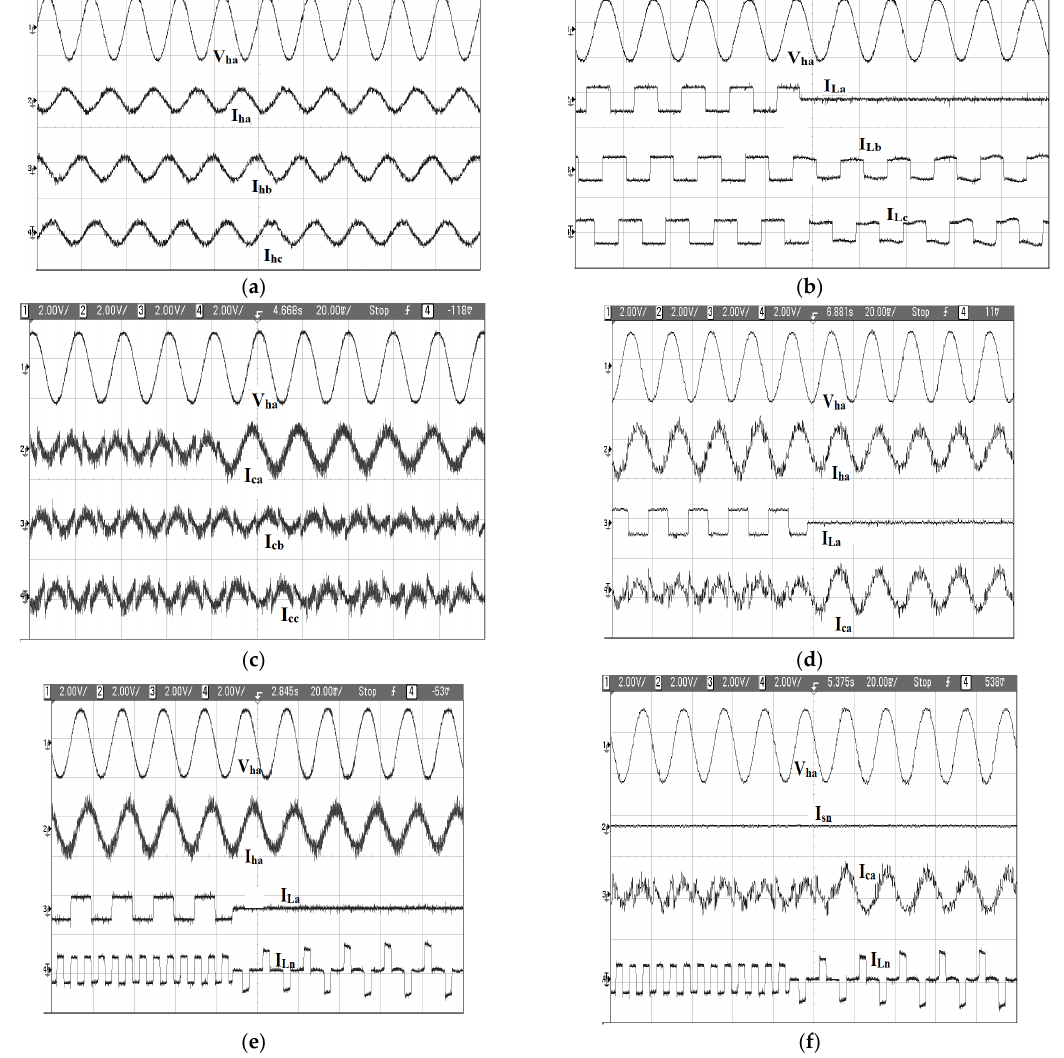
Figure 14. ( a ) source voltage and source currents in 3 phases under normal conditions ( b ) Source voltage and load currents in 3 phases when phase ‘a’ is disconnected ( c ) Source voltage and compensating currents in 3 phases when phase ‘a’ is disconnected ( d ) Source voltage, source current, load current and compensating current when phase ‘a’ is disconnected ( e ) Source voltage, source current, load current and load neutral current when phase ‘a’ is disconnected ( f ) Source voltage, source neutral current, compensating current and load neutral current when phase ‘a’ is disconnected.